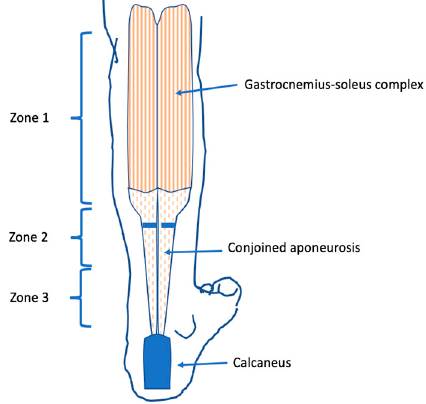
Figure 1. Line drawing transversely in Zone 2, showing the location of the transverse Vulpius gatrocsoleus